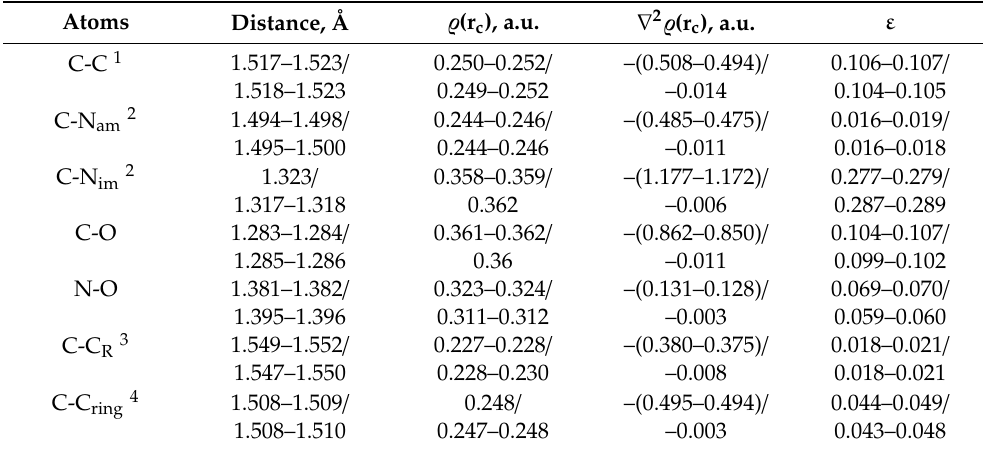
Table 2. Optimized interatomic distances and topological parameters at the (3,-1) critical points of the covalent bonds in the [Bi(15-MC Cu(II)Tyrha -5)] 3 + / [La(15-MC Cu(II)Tyrha -5)] 3 + complexes. The level of DFT calculations is SR-PBE / rL2.